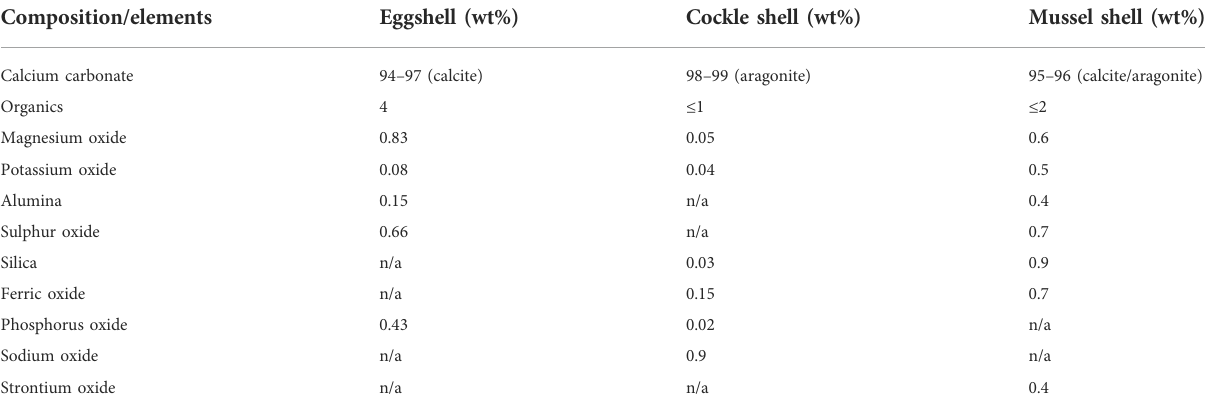
TABLE 1 Chemical composition of eggshell, cockle shell, and mussel shell (Hunton., 2005; Awang et al., 2007; Hamester et al., 2012; Chakraborty et al., 2020; Balá ž et al., 2021).